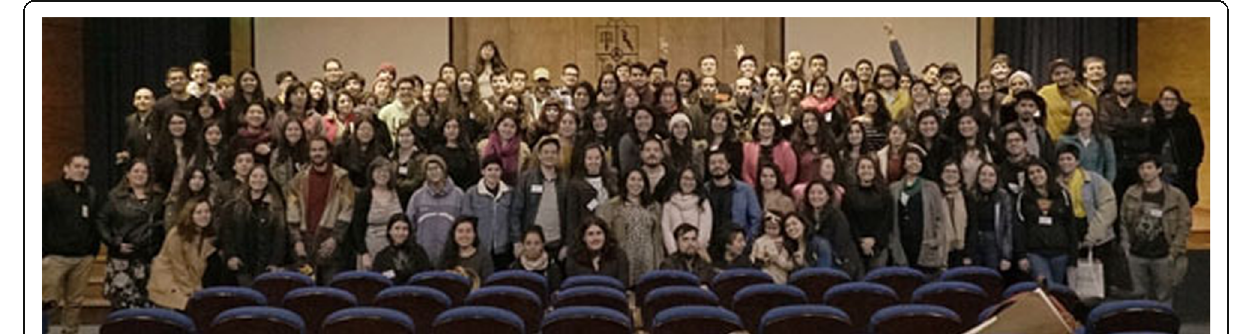
Fig. 7 Participants of the 1st Chilean Meeting of